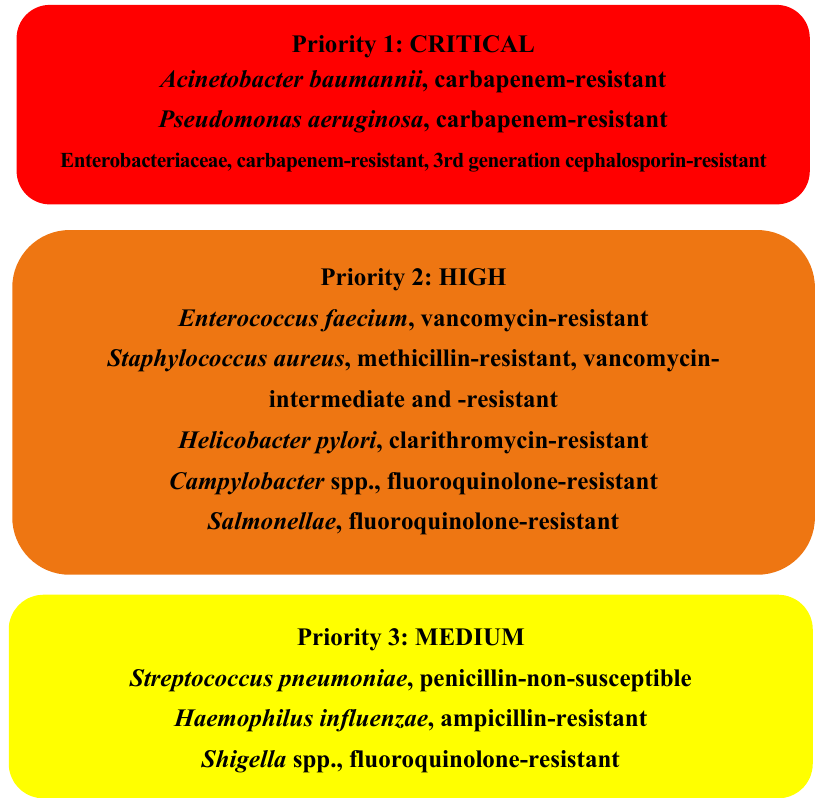
Figure 1. WHO list of priority pathogens for research and development of new antibiotics [6,7].